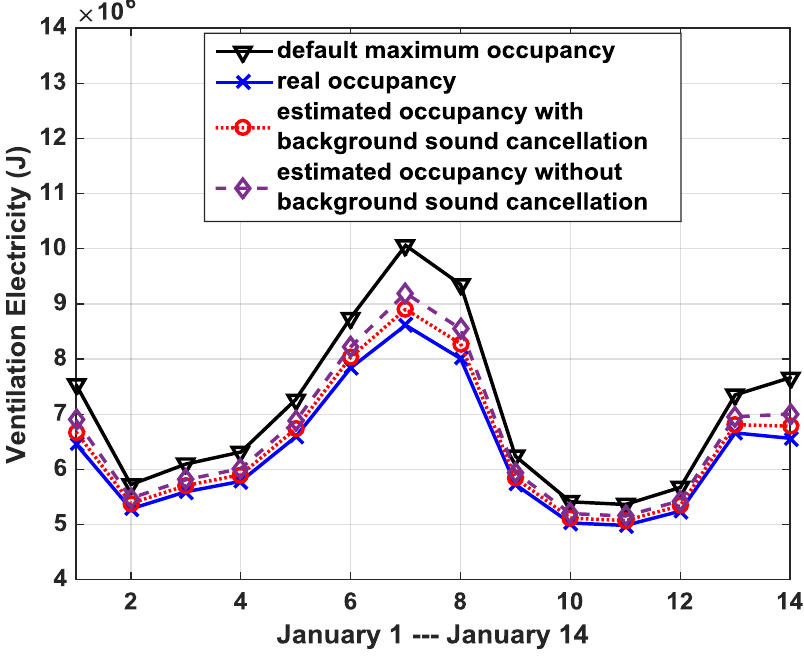
Figure 8. Simulation results of daily ventilation electricity for two weeks in January.